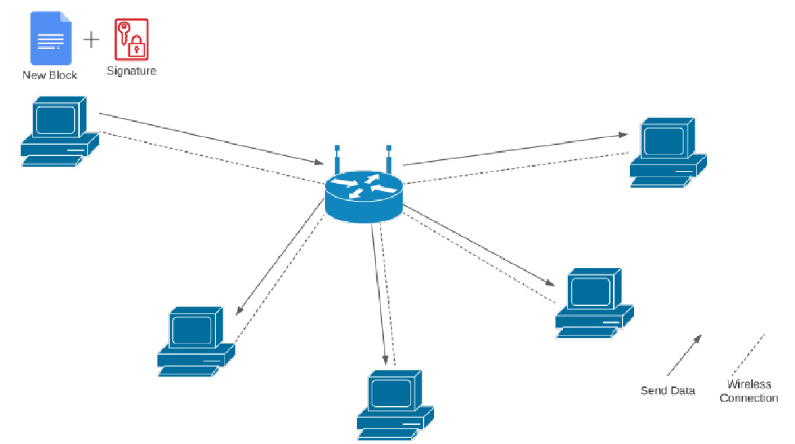
Figure 6. Block creation and digital signature.